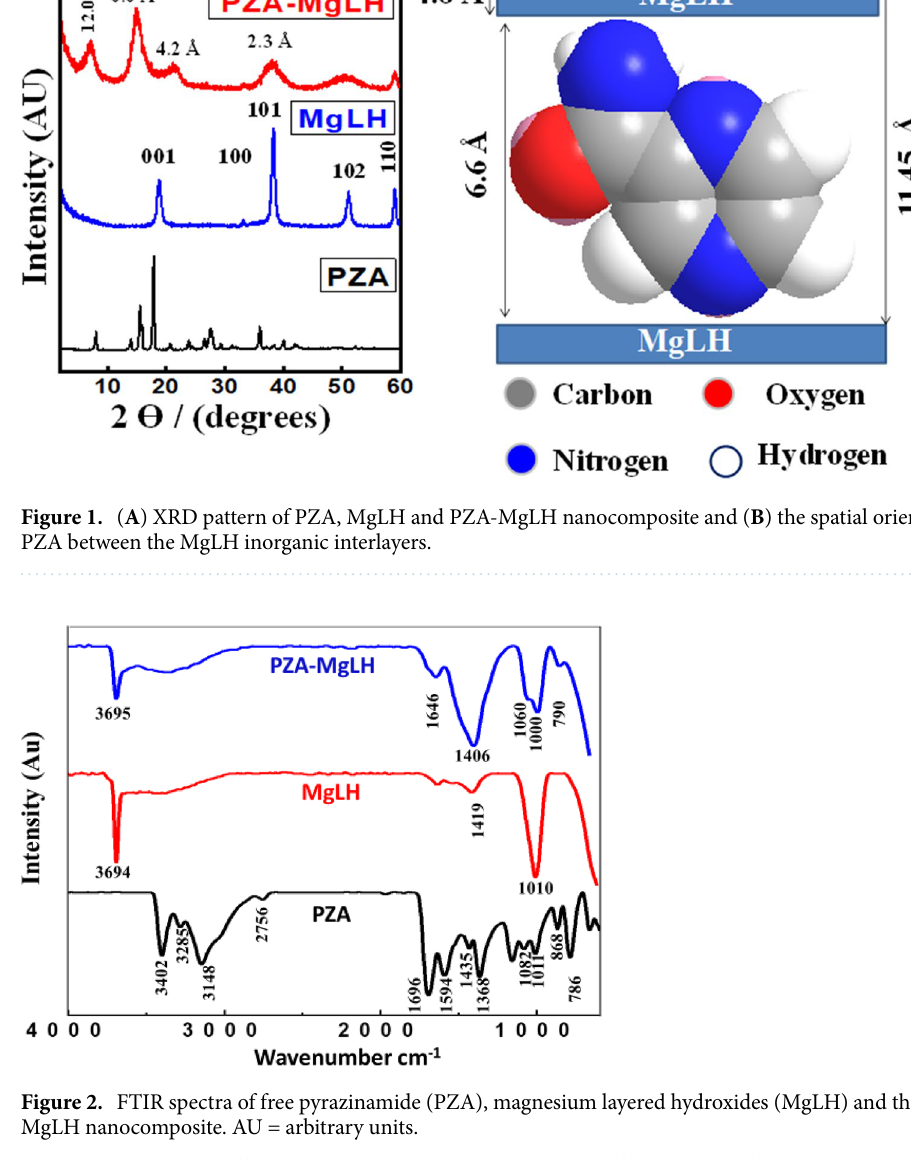
indicating the successful intercalation of PZA into the interlayer galleries of MgLH. The details of the vibration bands of free PZA, MgLH and PZA-MgLH are given in Table 1. Elemental analysis and drug loading. The XRD and FTIR results were further complemented by ICP- OES and HPLC analyses. The percentage of Mg in the composites was determined using inductively coupled plasma (ICP-OES) and the amount of PZA loading was determined by high-performance liquid chromatogra- phy (HPLC) analyses. Based on the ICP-OES results, 58% of Mg was found to be present in the nanocomposite, PZA-MgLH. HPLC analysis. The percentage loading of the active drug, PZA, was determined using the HPLC technique, as was previously reported with slight modifications 34 . In brief, the following parameters were used; the oven temperature was set at 30 °C and the mobile phase was set at a flow rate of 1 mL/min. The retention time of PZA was found to be 2.2 min and a wavelength of 235 nm was selected for the UV detector. The mobile phase was acetonitrile (A) and a potassium dihydrogen phosphate buffer at 15 mmol L −1 with the pH adjusted to 4.0 ± 0.1 with phosphoric acid (B). The samples were run in an isocratic mobile phase comprising a ratio of 89:11 for the A: B solvents. The standard drug, PZA solutions, and the samples were prepared in 5 mL of a 1 molar hydrochlo-